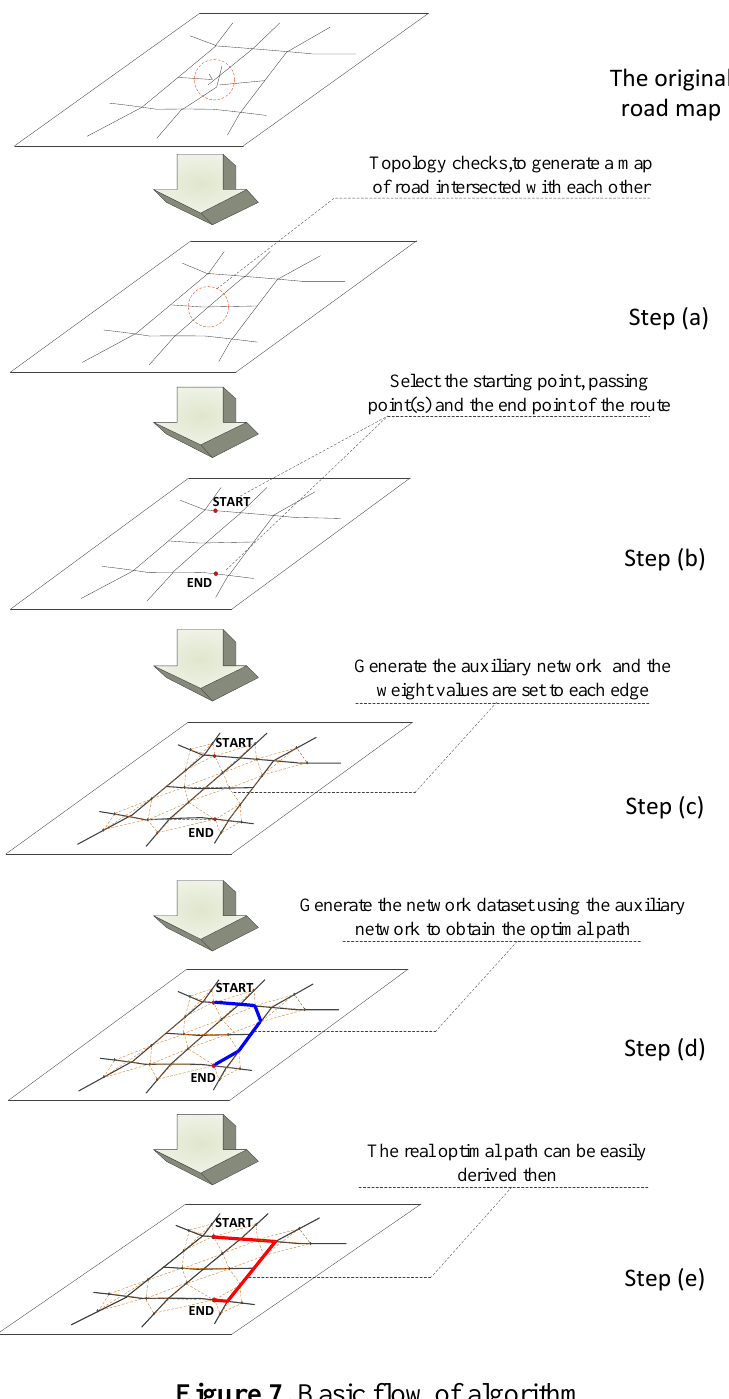
Figure 7. Basic flow of